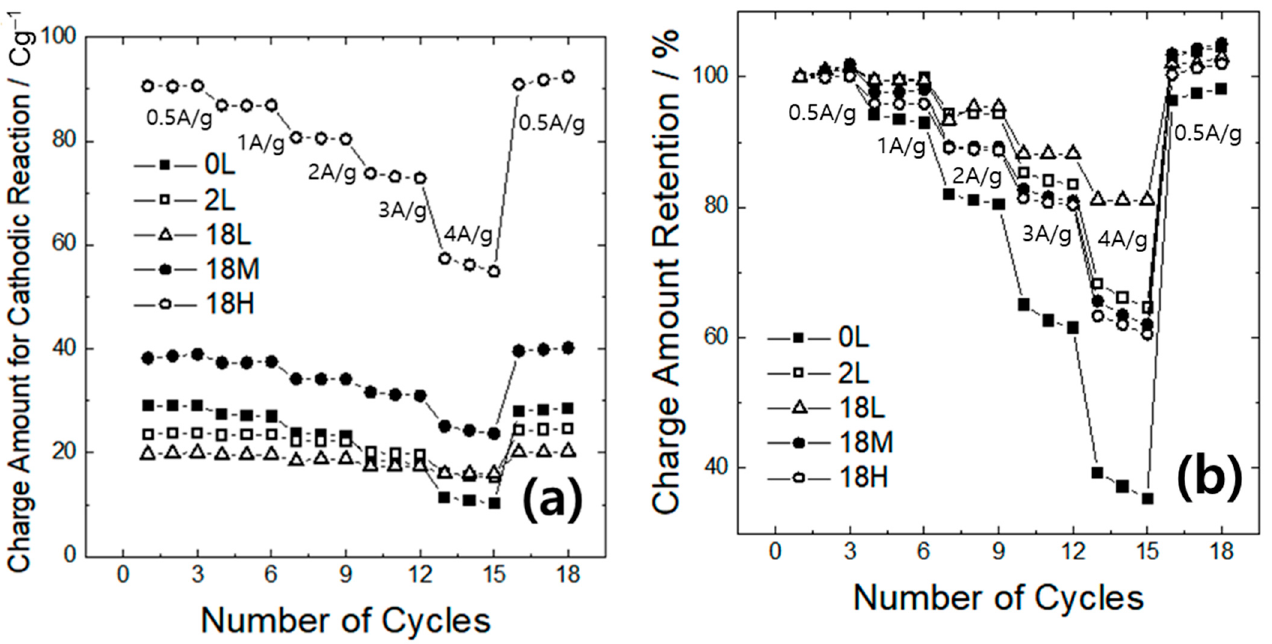
Figure 6. Rate characteristics of the samples. ( a ) Amount of cathodic charge amount and ( b ) charge amount retention at different cathodic current densities.